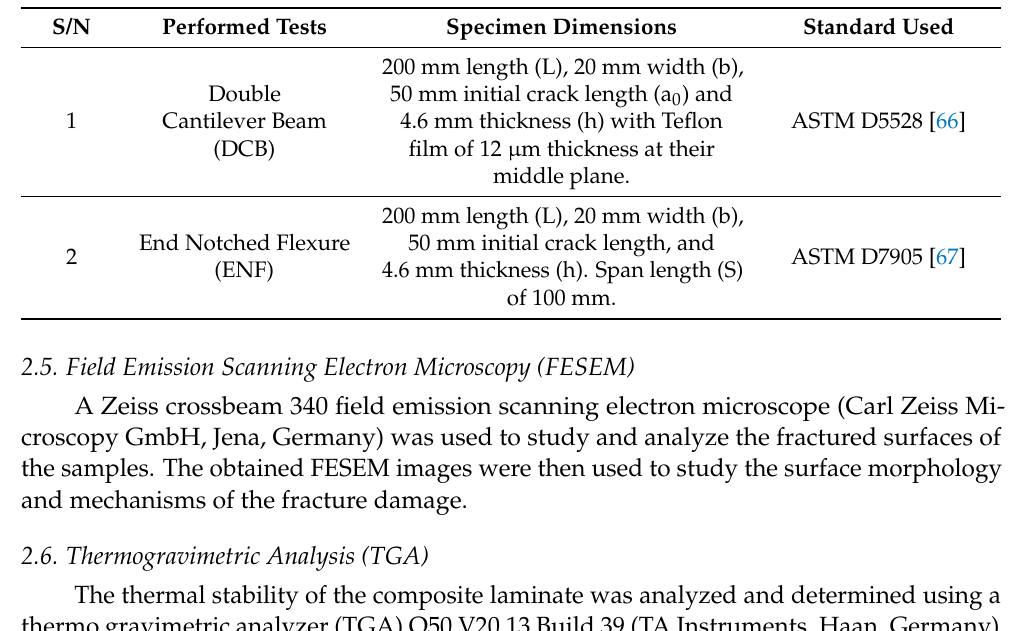
Table 2. Tabulation of the specimens used in this